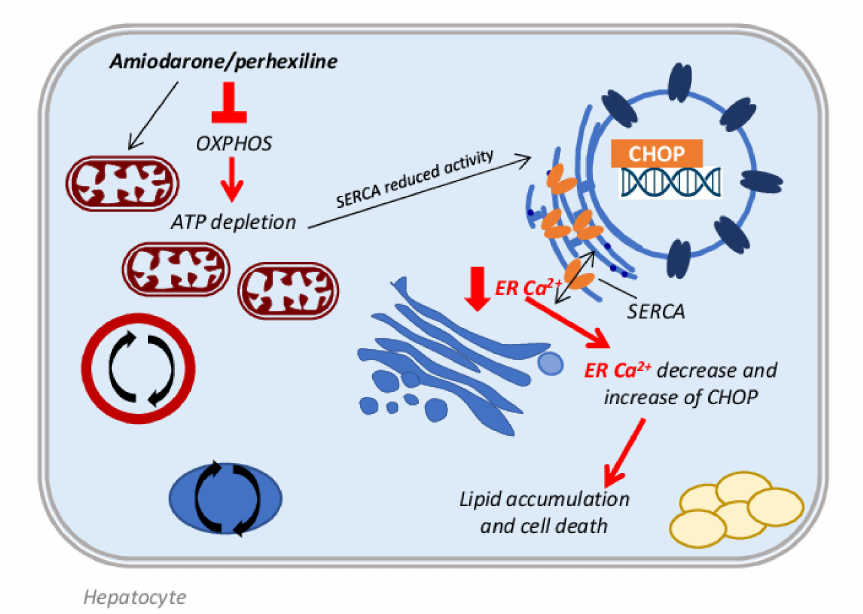
Figure 2. Schematic representation of one of the molecular mechanisms involved in amiodarone/perhexiline-induced NAFLD. The ATP depletion caused by amiodarone/perhexiline interference with OXPHOS leads to the reduced activity of the smooth endoplasmic reticulum Ca 2+ pump (SERCA). The reduction in ER Ca 2+ produces ER stress and the upregulation of CHOP activity with consequent increase in the activity of the lipid droplet proteins cell death activator (Cidea), cell death inducing DFFA like effector C (Cidec), and perilipin-2, which are involved in lipid